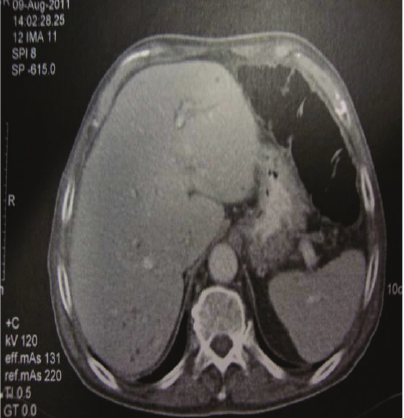
Figure 2: Abdominal CT showing hypodense lesions located in the liver and spleen and enlarged retroperitoneal lymph nodes.